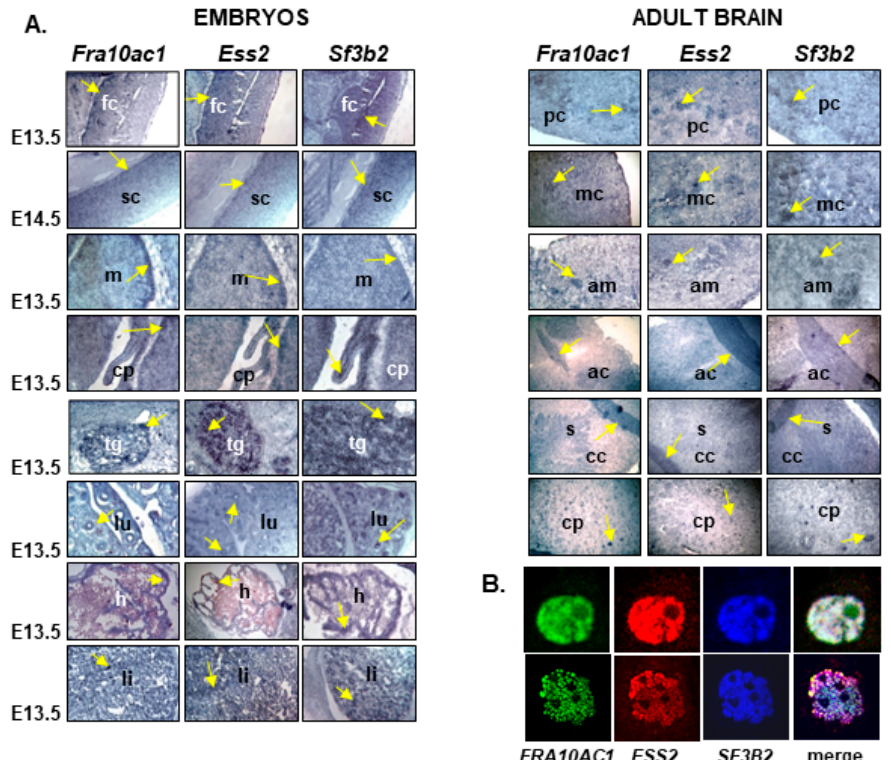
Figure 3. ( A ) Fra10ac1 , Ess2 , and Sf3b2 show spatial co-expression in mouse tissues. Comparative expression analysis of Fra10ac1 , Ess2 , and Sf3b2 through RNA in situ hybridization on sagittal mouse embryo sections and coronal sections of adult mouse brain. In embryos, co-expression of the genes was detected in frontal cortex (fc), spinal cord (sc), midbrain (m), choroid plexus (cp), trigeminal nerve (tg), lung (lu), heart (h), and liver (li). In the adult brain, overlapping regions of expression included the piriform cortex (pc), motor cortex (mc), amygdala (am), anterior commissure (ac), and caudate putamen (cp). ( B ) Co-localization of FRA10AC1, ESS2, and SF3B2 in the HeLa cell nucleus. FRA10AC1 was detected by direct GFP fluorescence. ESS2 and SF3B2 were detected by anti-Xpress and anti-SF3B2 antibodies followed by fluor secondary antibodies. In the majority of cells, a diffused nucleoplasmic pattern was observed (upper panel), while in ~10% of cells, a punctuate pattern was detected in over-expressing FRA10AC1 and ESS2 cells (lower panel). Nuclear staining was per- formed with DAPI (not shown). The merged images reveal the co-localization of the proteins.